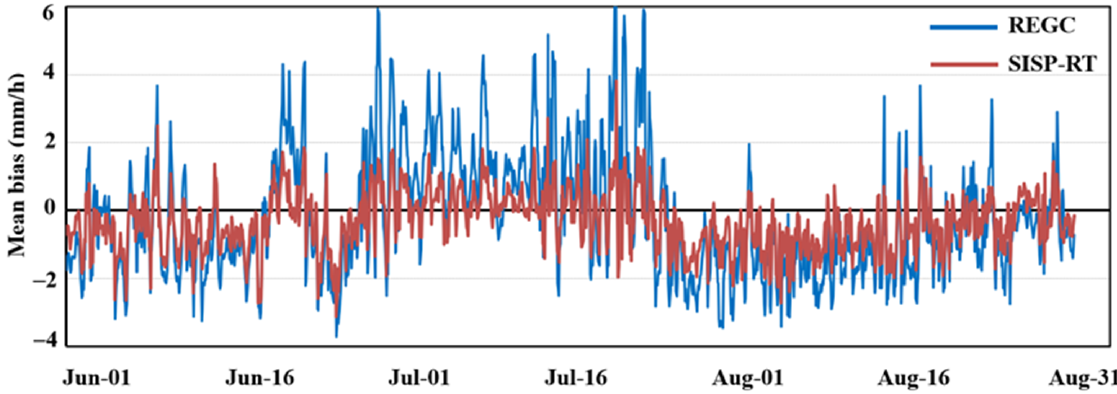
Figure 6. Time series of mean biases for REGC and SISP-RT at hourly scale in June–August 2019.